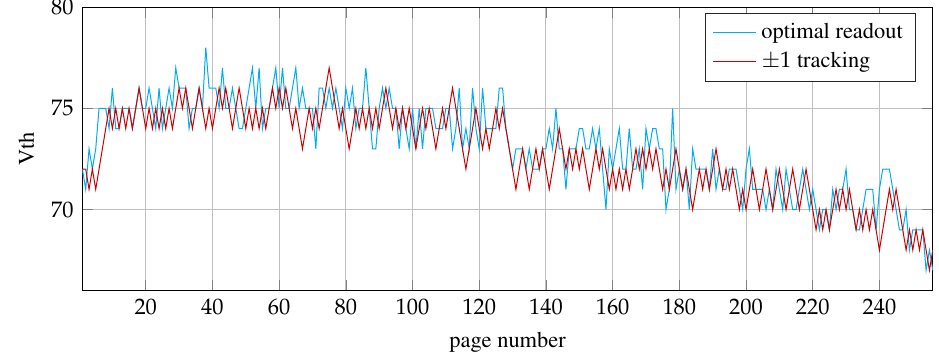
Figure 12. Threshold voltage adaptation of a TLC-Block on reference r 3 (55h bake, 3000 P/E).